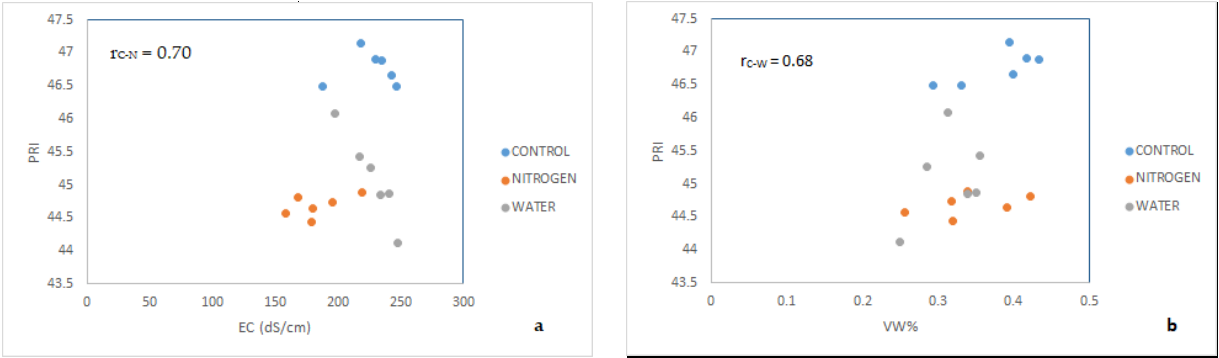
Figure 8. Pearson’s correlation for PRI between ( a ) chlorophyll content index (SPAD), ( b ) photosyn- thetic efficiency (As in μmol/m 2 s), and ( c ) stomatal conductance (g s in mol H 2 O/m 2 s). For the plants under nitrogen stress, the analysis between PRI and EC showed a strong correlation ( p < 0.05) with a correlation coefficient of 0.70 (Figure 9a). Additionally, the plants under water stress showed a significant correlation ( p < 0.05) between PRI and the water content of the substrate, with a correlation coefficient of 0.68 (Figure 9b).